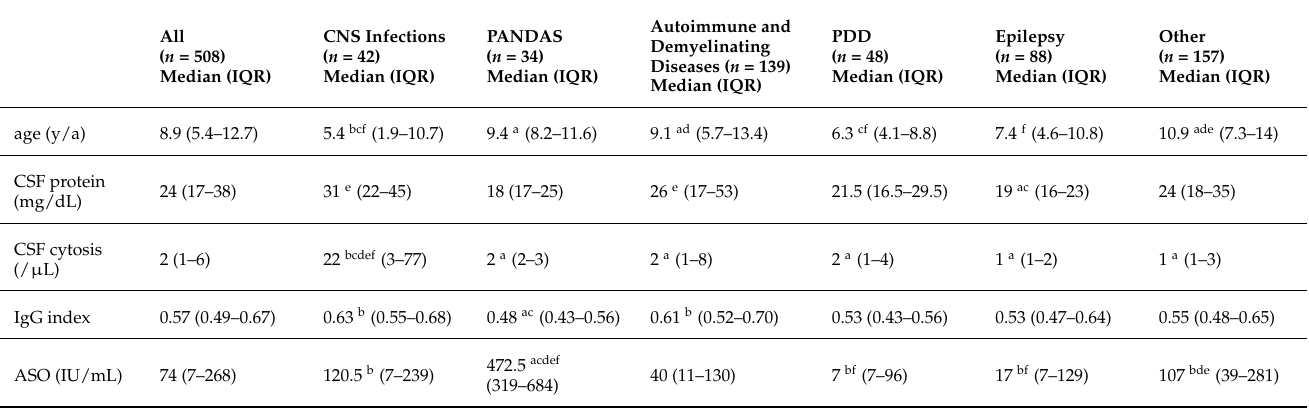
Table 2. Median and IQR values of analysed